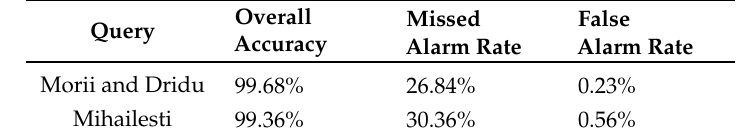
Table 2. Performance evaluation on short SITS.